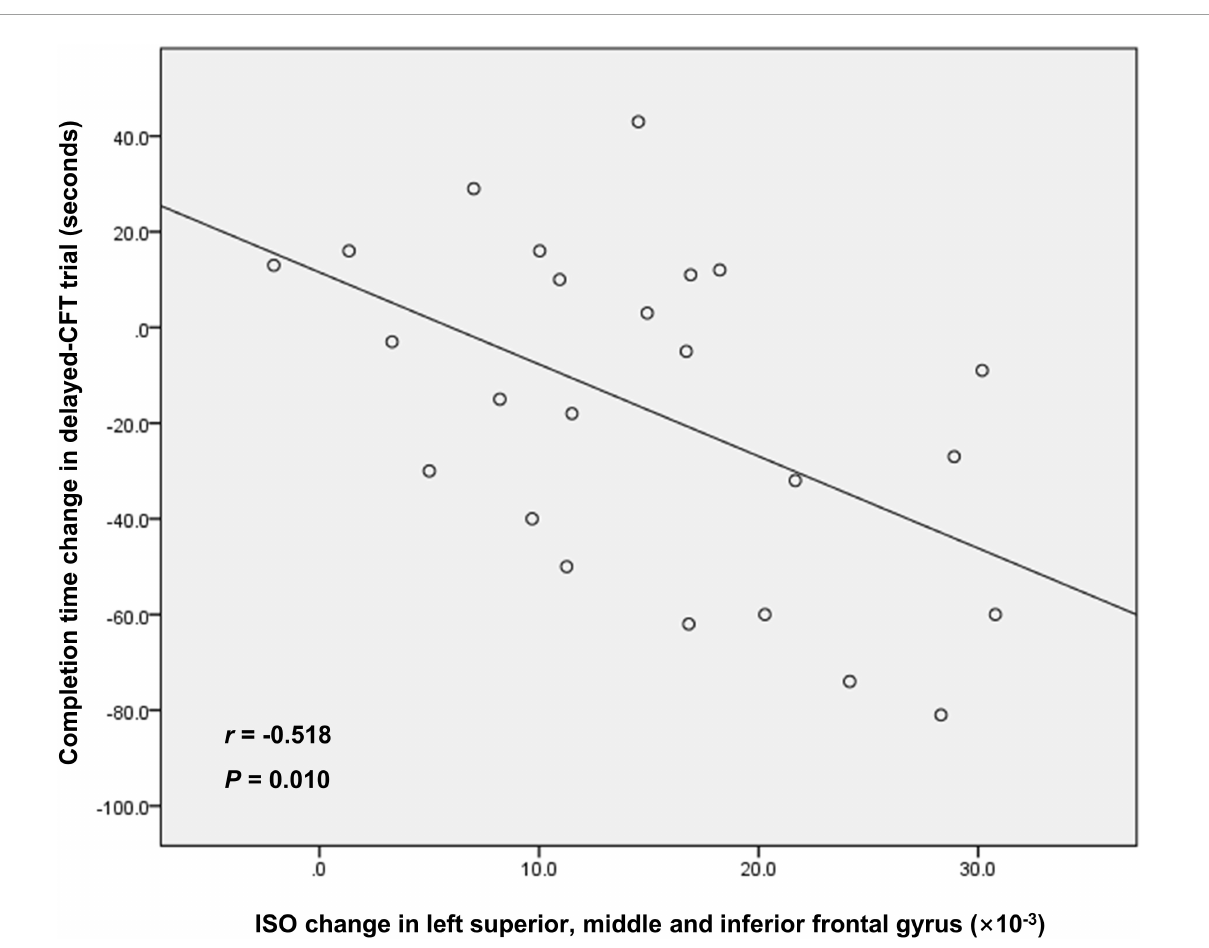
After SD, subjects showed ISO reductions in the